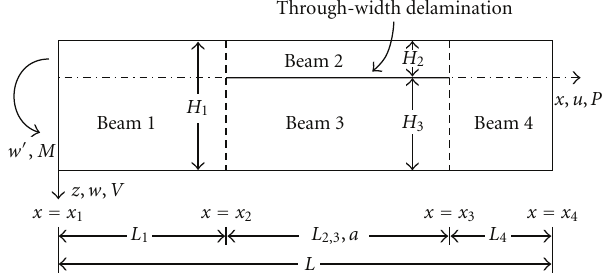
Figure 1: The coordinate system and notation for a delaminated composite beam.